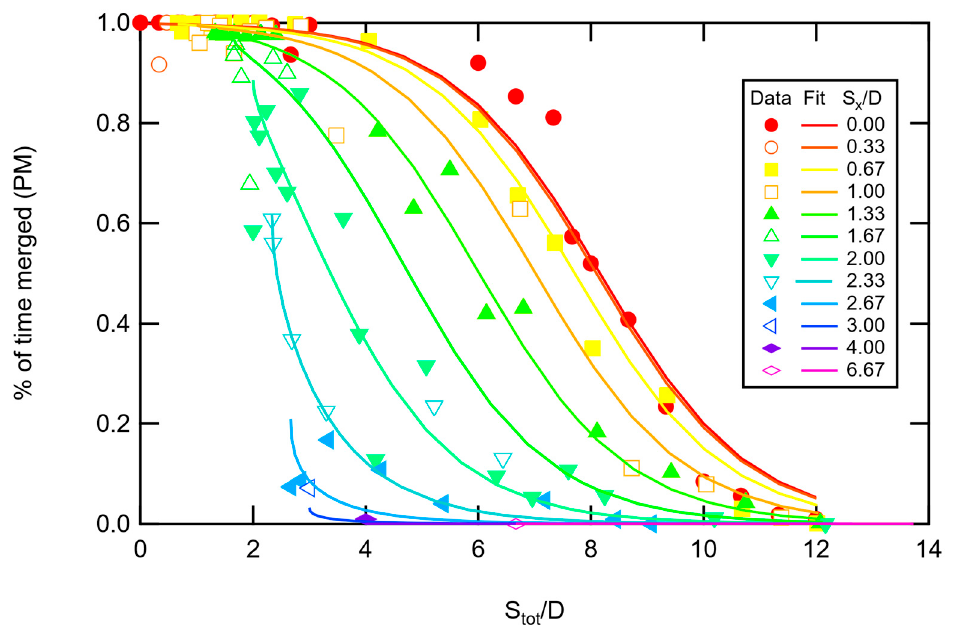
Figure 8. Merging probability ( PM ) as a function of normalized distance for the two-pad experiments. Lines are the curve fits using Equation (6). Error bars omitted for ease of viewing.